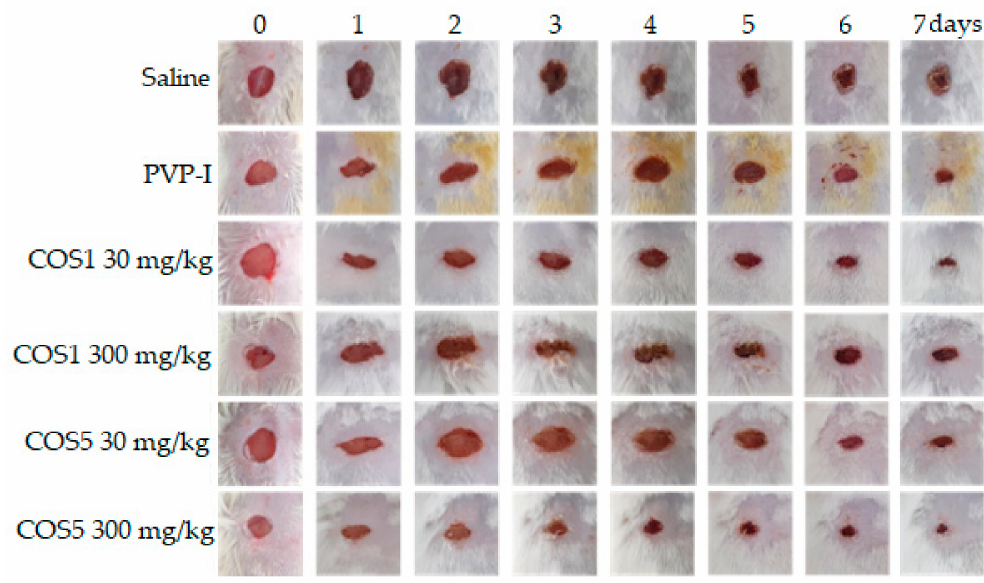
Figure 9. Representative effects of COS1 and COS5 on skin wound healing in vivo.